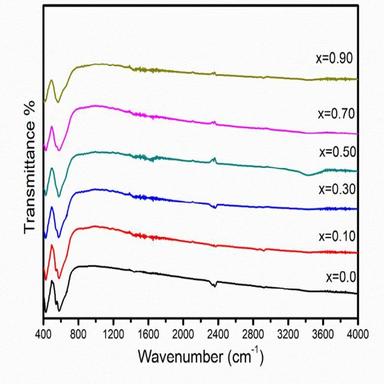
FTIR spectra of BaZnxZrxFe(12-2x)O19 (x=0, 0.1, 0.3, 0.5, 0.7, and 0.9)